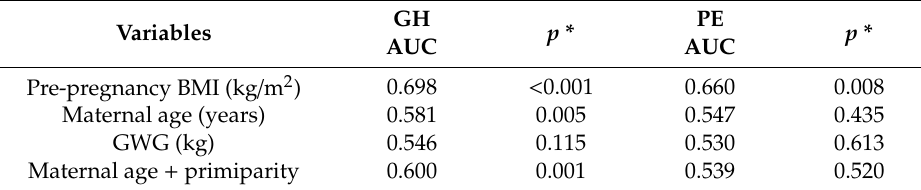
Table 3. Area under curve (AUC) values for predicting GH and